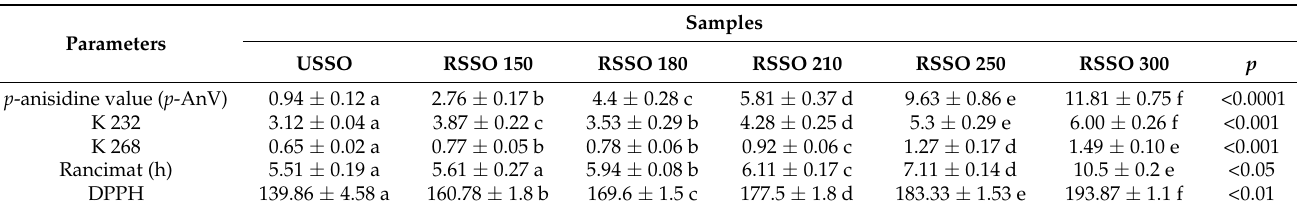
Table 6. Evaluation of the oxidative stability and antioxidant activity of raw and roasted sesame seed oils at different temperatures.